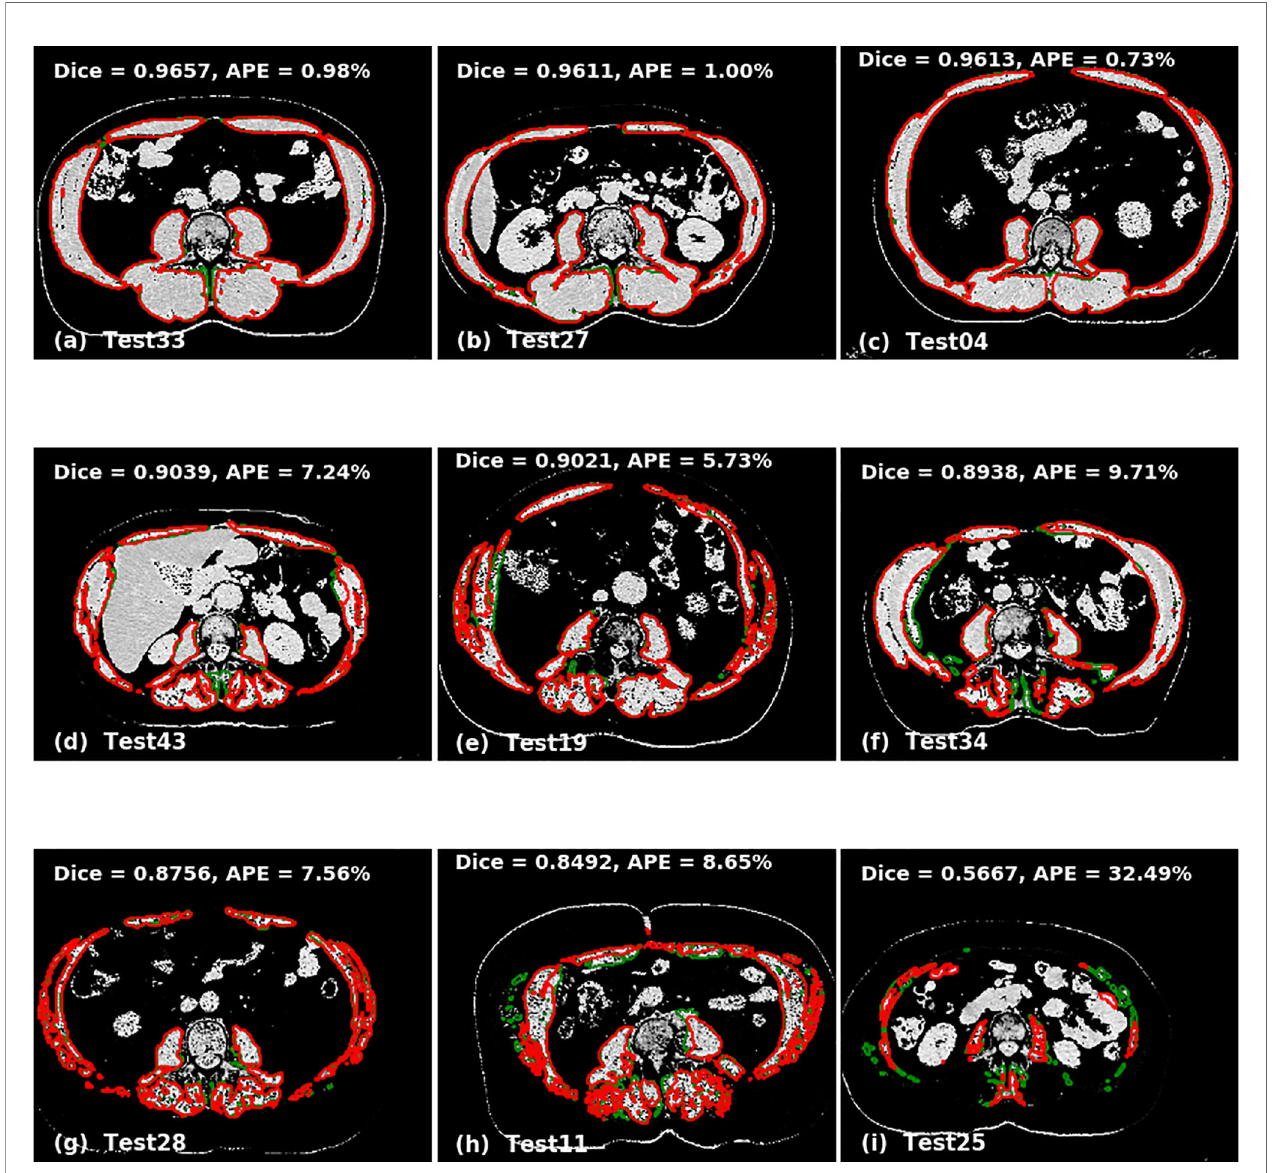
FIGURE 4 | Qualitative performance of the model on Cohort 2. Red represents deep learning contours and green represents manual contours. Panels (A – C) in the top panel show three of the best performing cases (Dice ± 0.96). Panels (D – F) in the middle panel show the cases with average performance (Dice ± 0.90) and Panels (G – I) in the bottom panel show cases with lowest performance (Dice ±